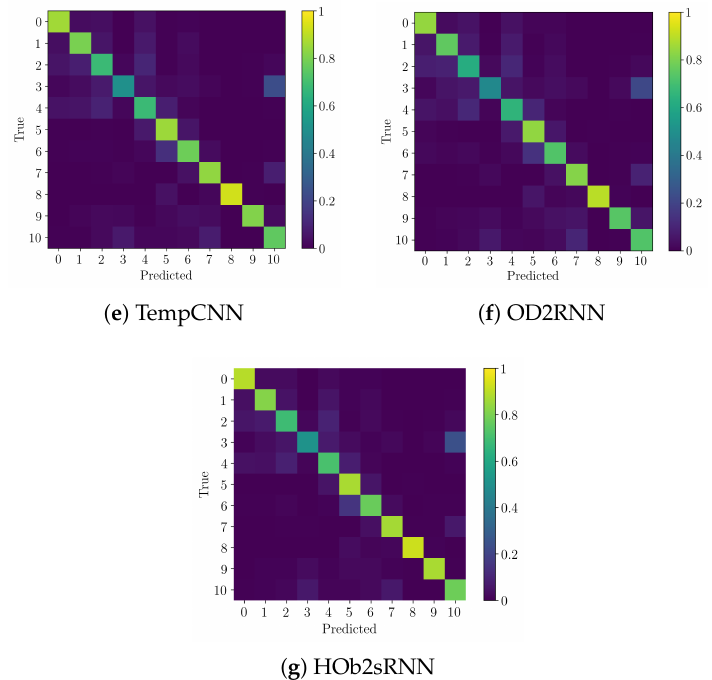
Figure 11. Confusion matrices of the land cover classification produced by ( a ) RF POE , ( b ) RF, ( c ) SVM, ( d ) MLP, ( e ) TempCNN, ( f ) OD2RNN and ( g ) HOb2sRNN on the Reunion island. See Table 1 for corresponding labels.